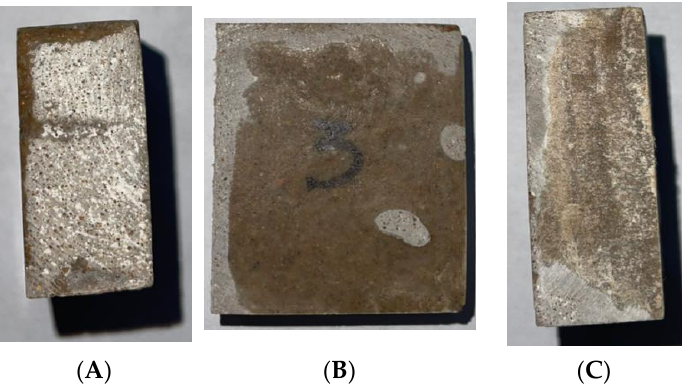
Figure 1. Sample No. 3 (polymer-concrete composition No. 15). ( A ) Top view; ( B ) Front (main) view; ( C ) Right side view.